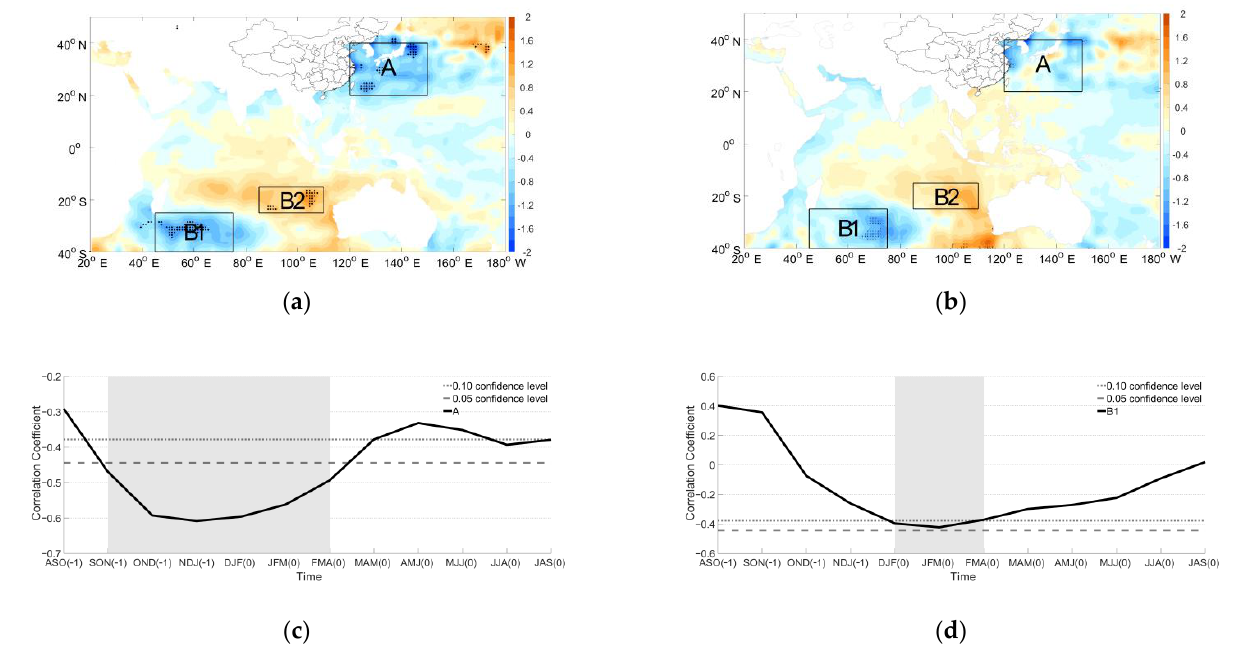
Figure 5. Field of the preceding winter ( a ) and spring ( b ) of high- and low-NPP years in the key climatic area (shadow, unit: ◦ C; dot = 0.05 reliability test); sliding correlation coefficients between the annual NPP and the seasonal mean SST in region A ( c ) and region B1 ( d ) ( − 1: the preceding year; 0: the same year).